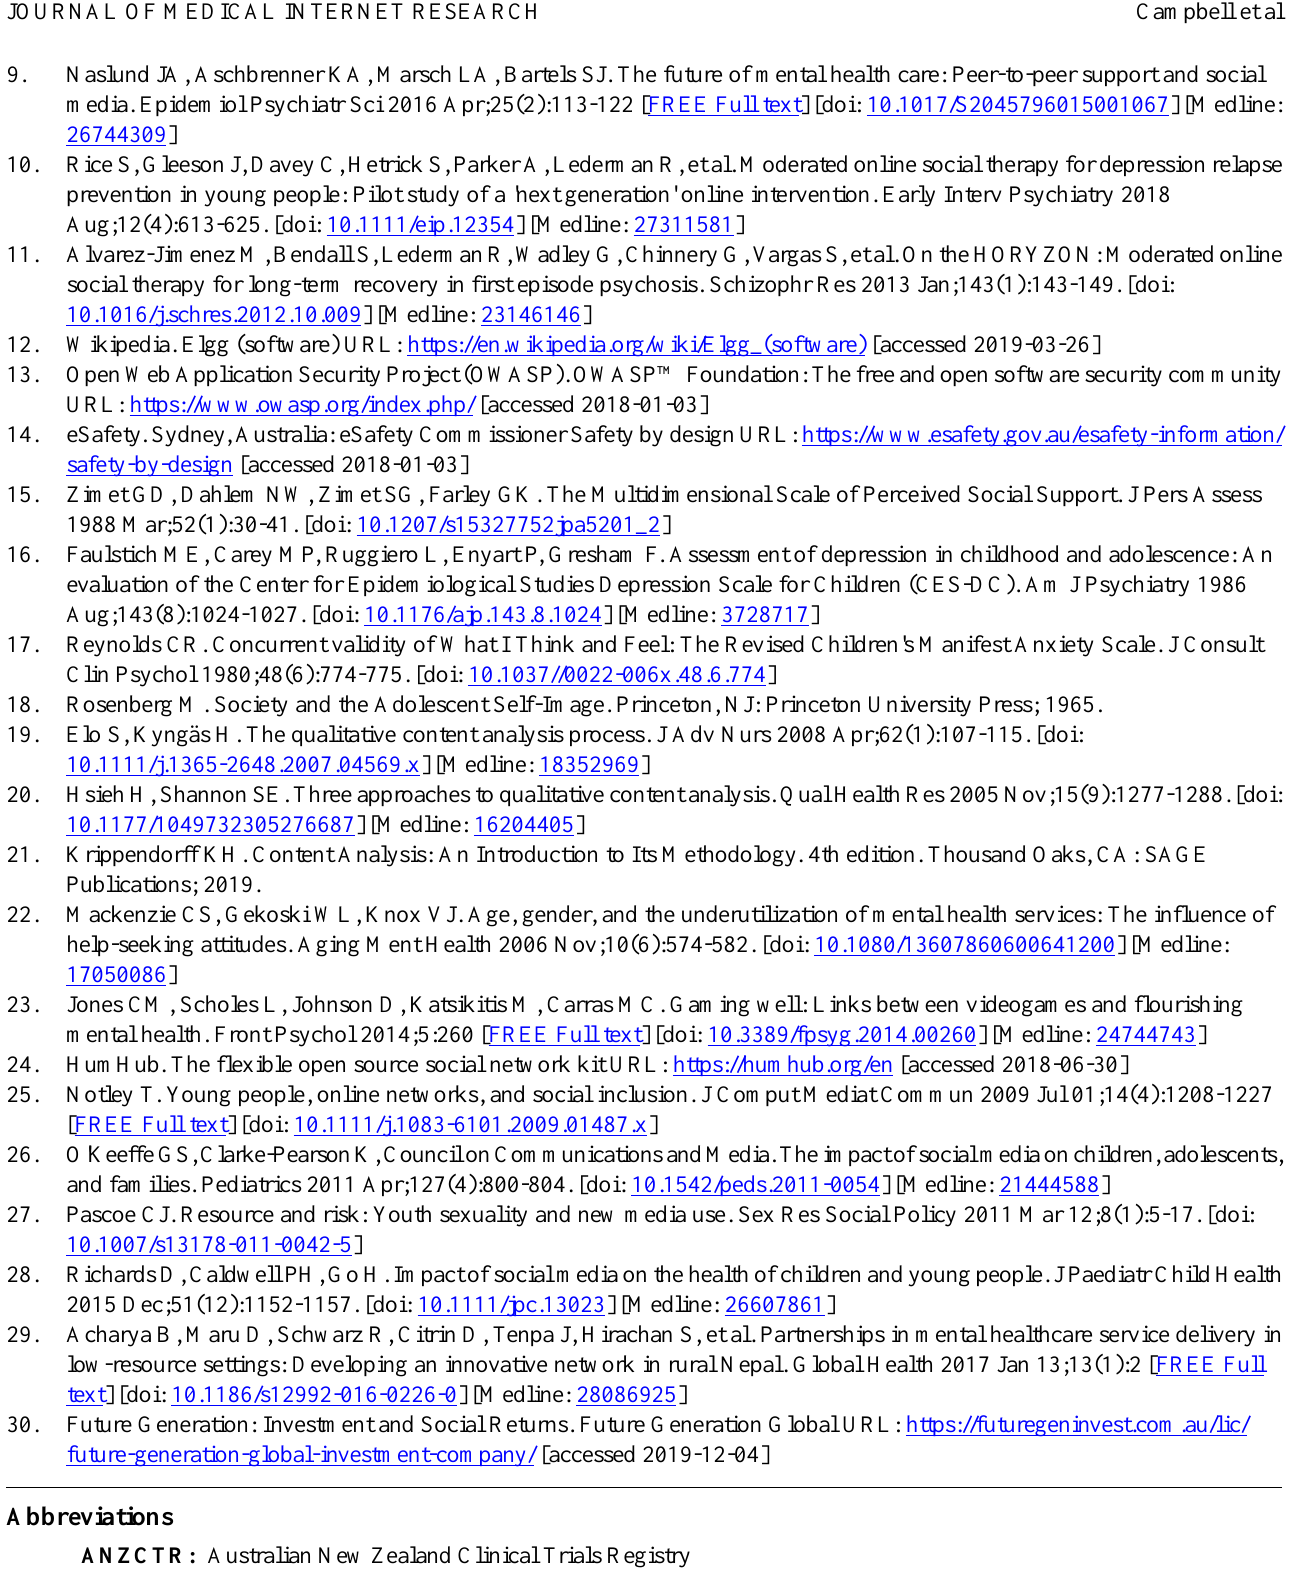
FGX: Future Generation Investment Fund HTTPS: HTTP Secure KHL Circles: Kids Helpline Circles PAR: participatory action research SNS: social networking site